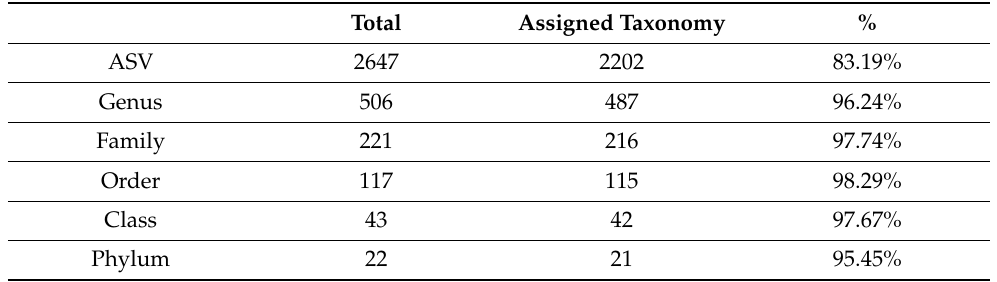
Table 2. Summary of the taxonomic analysis of the obtained ASVs. Taxonomic assignment was performed using the SILVA 138 database. Total Assigned Taxonomy % ASV 2647 2202 83.19% Genus 506 487 96.24%